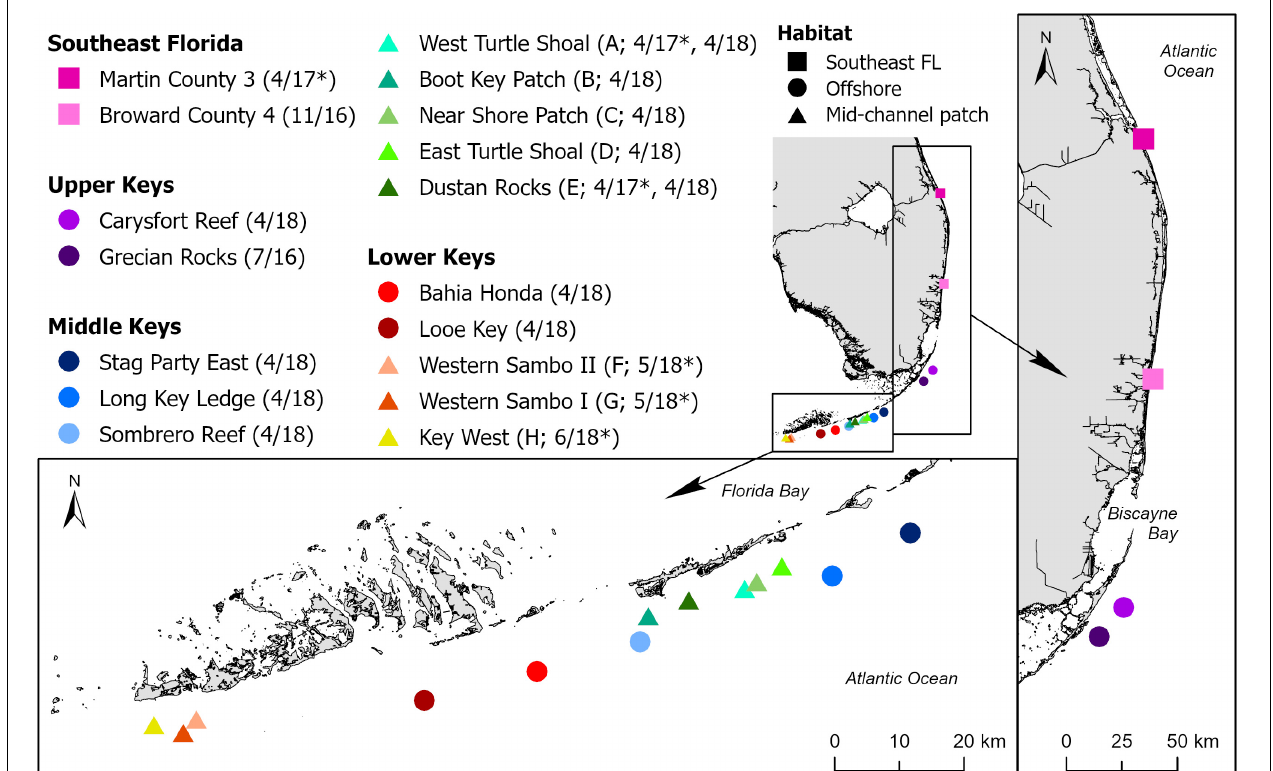
FIGURE 1 | Sites along the Florida Reef Tract at which corals were sampled for stony coral tissue loss disease (SCTLD) histological analysis. Sites are in four regions (Southeast Florida [SE FL] and the Upper, Middle, and Lower Keys) and three general reef habitats (SE FL, offshore, and mid-channel patch). Project site codes = A – H used in Table 1 , sampling dates = MM/YY, * = site sampled before the arrival of